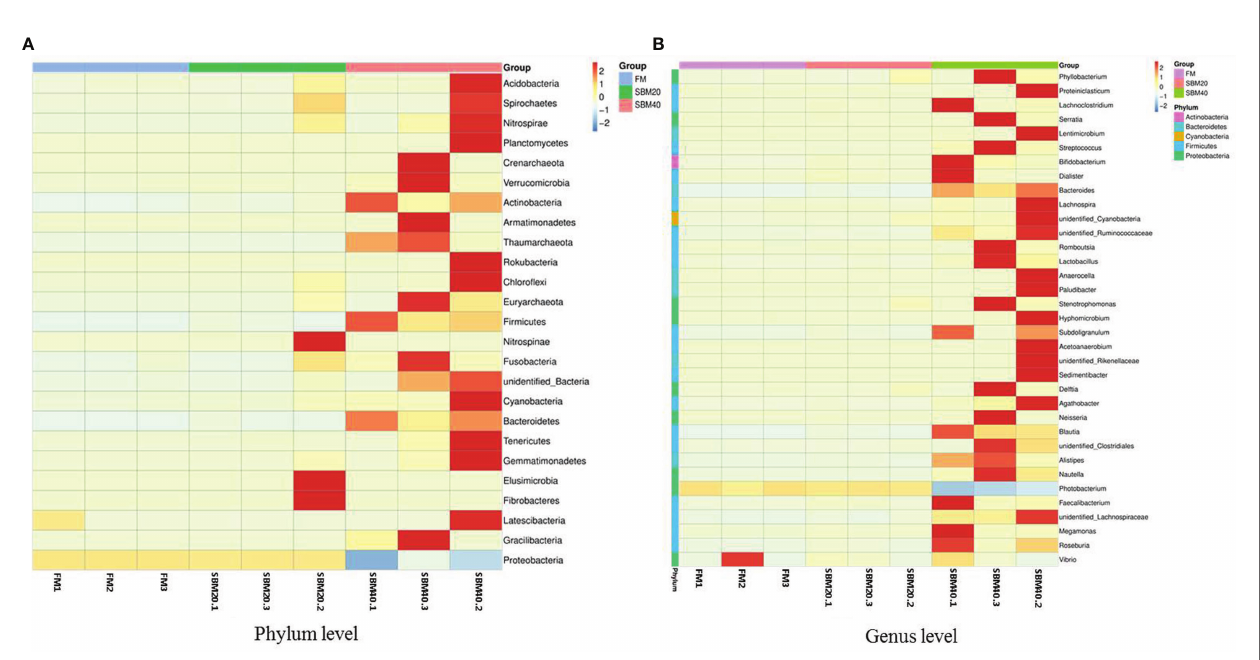
TABLE 5 | The b diversity index differences of intestinal fl ora of pearl gentian grouper fed by different levels of soybean meal diets ( n = 3). Group-pair Difference p-value Sig. FM-SBM20 − 1.66667